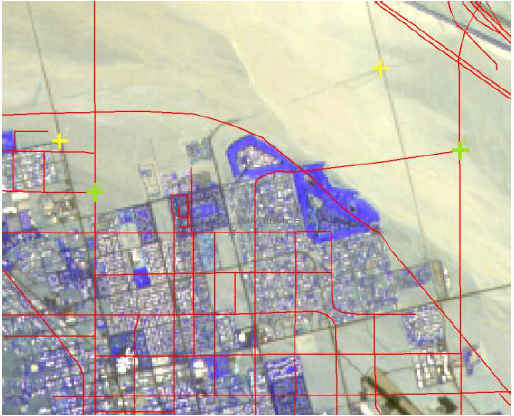
Figure 2. Georeferecing with control points